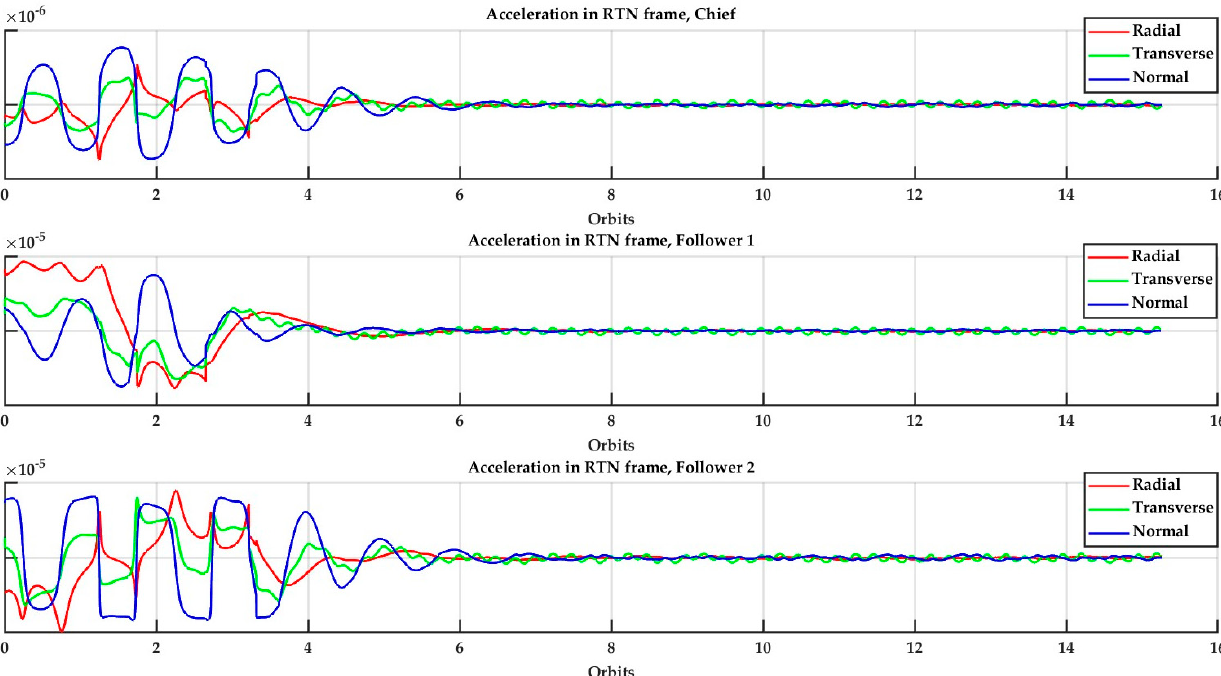
Figure 12. Control acceleration results with chief/follower mass ratio 𝛽 = 10 .